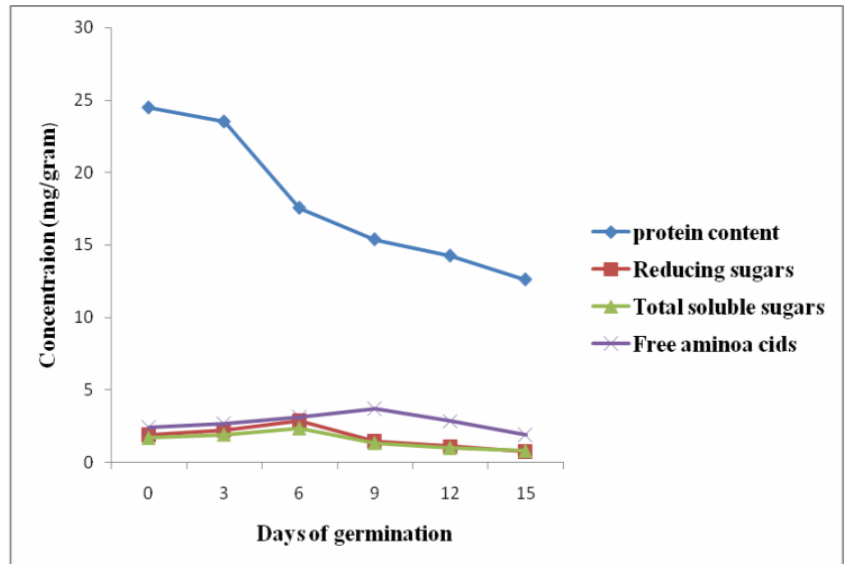
Fig. 1. Total proteins, amino acids, reducing and soluble sugar levels during seed germination (0-15 days)